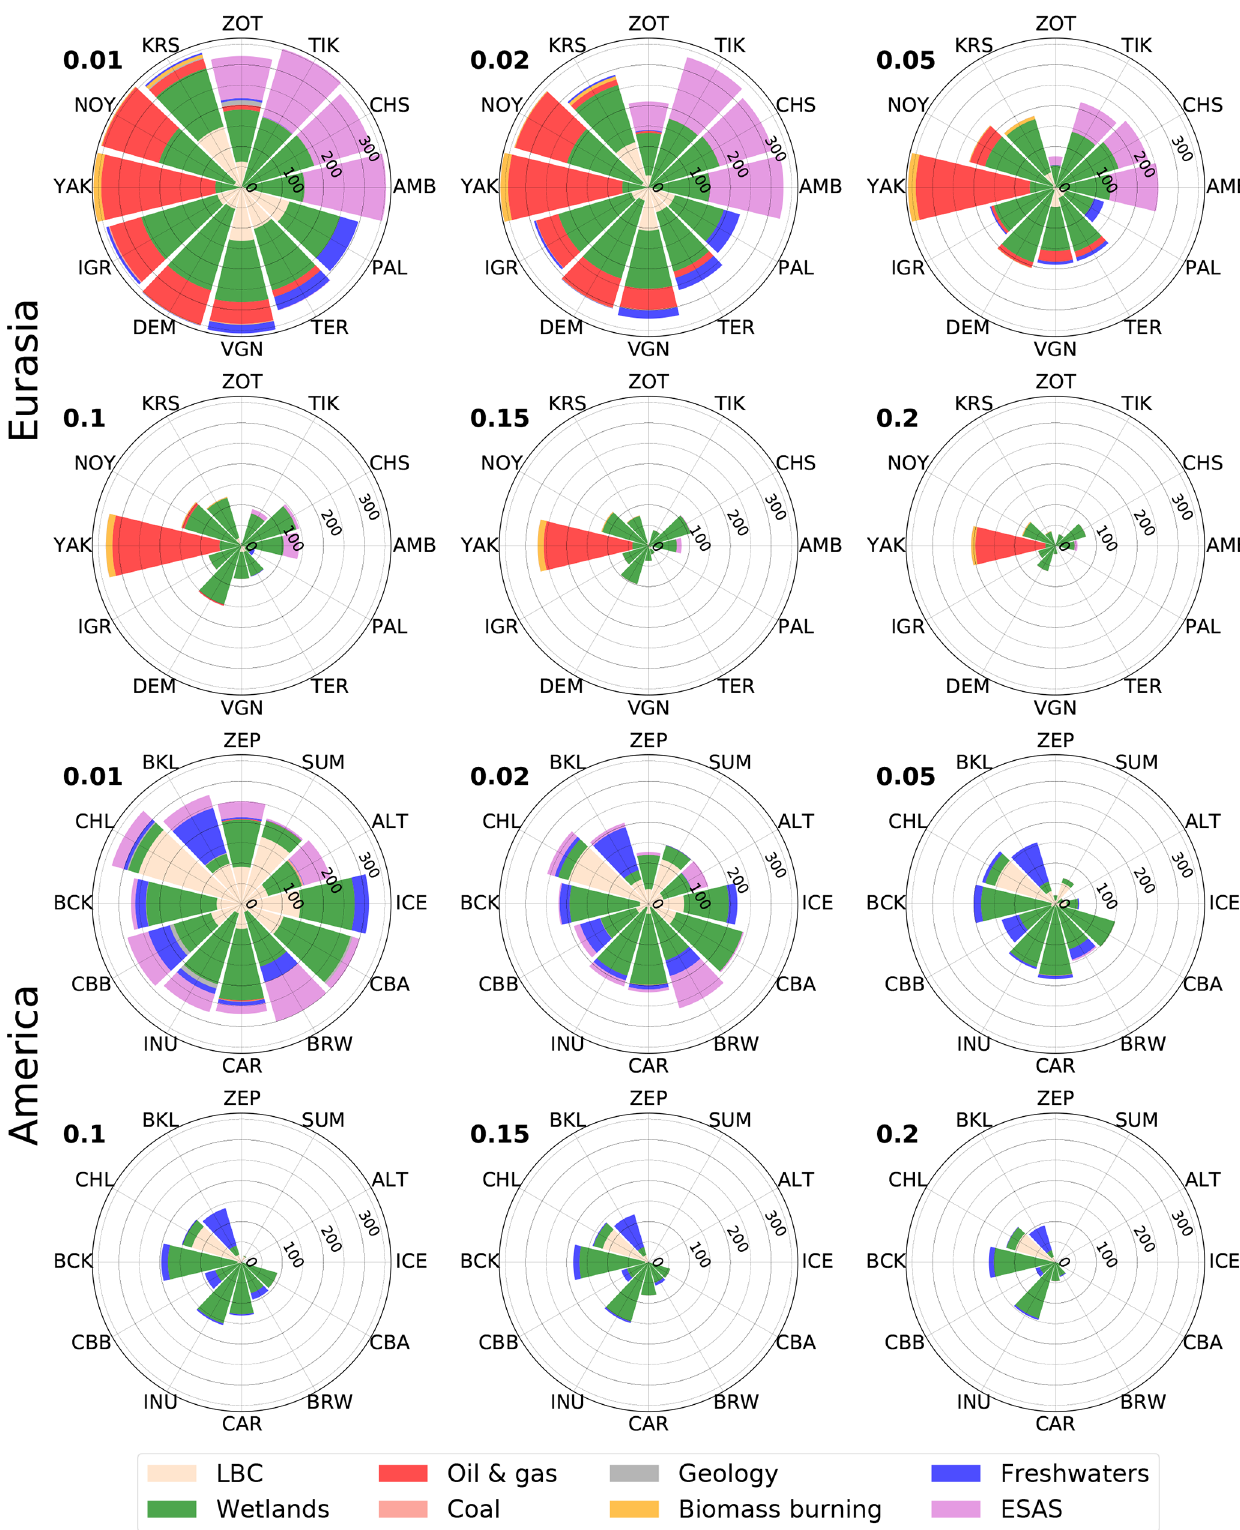
Figure 5. Number of days in 2012 when simulated daily direct contributions of northern high-latitude sources to the δ 13 C CH4 value are above given thresholds, for each of the 24 stations of Fig. 1. The numbers on the top left of each wind rose correspond to the threshold values. The coloured shades indicate the dominant northern high-latitude source in terms of δ 13 C CH4